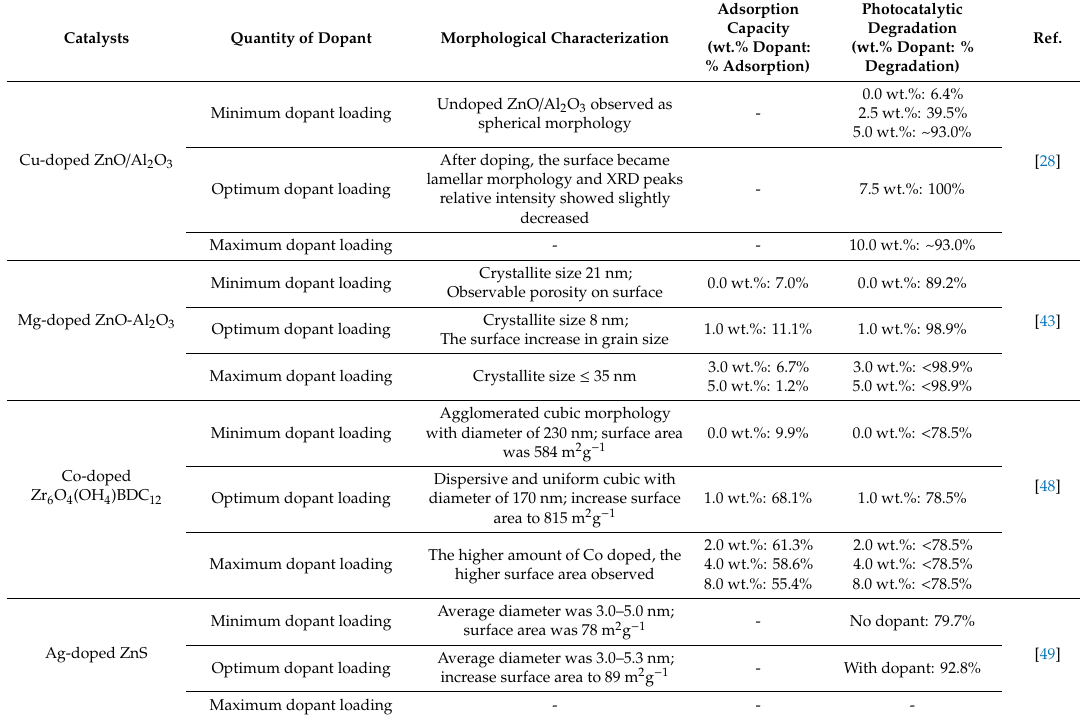
Table 2. E ff ect of di ff erent loading of dopant on the adsorption and photocatalytic degradation.